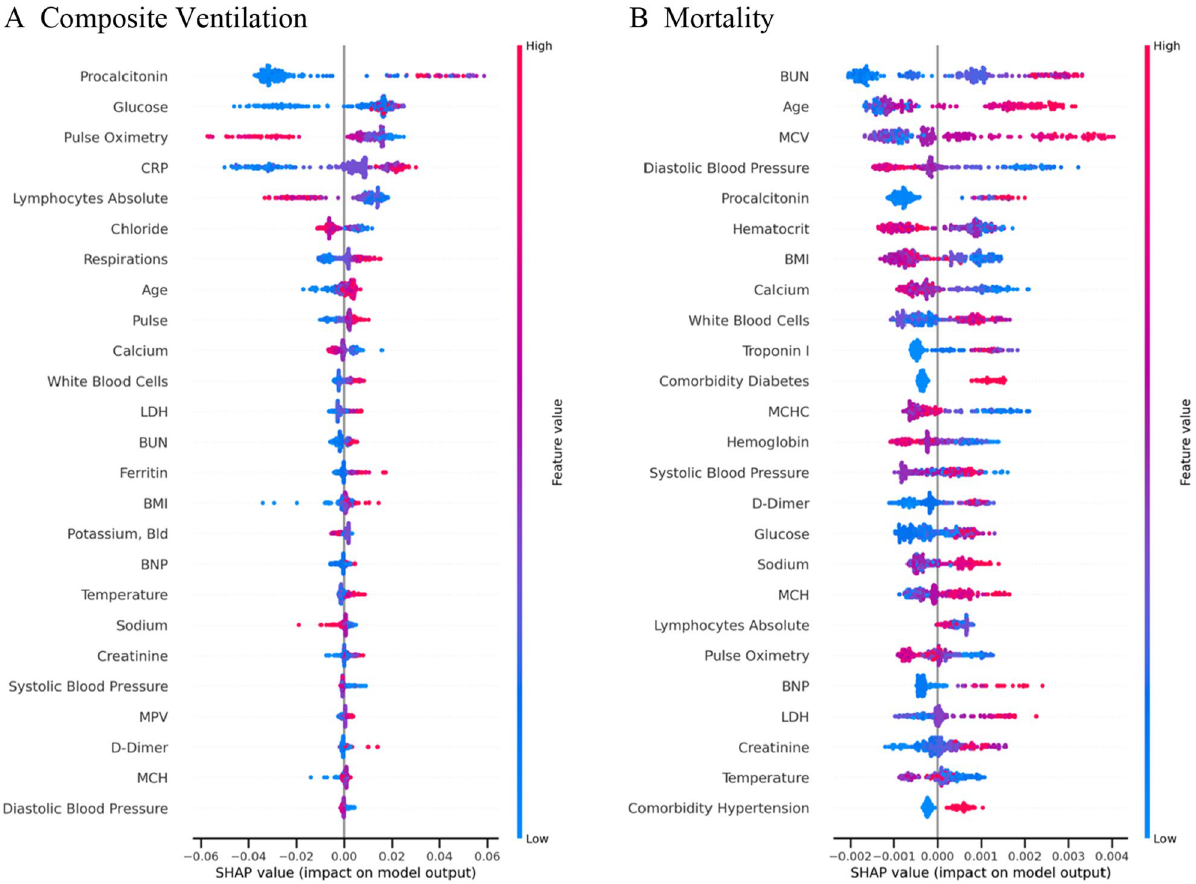
Figure 5. Scatter plots of SHAP values versus unnormalized values for selected features. ( A – C ) The top three most significant features for predicting composite ventilation for the best performing fold. ( D – F ) The top three most significant features for predicting mortality for the best performing